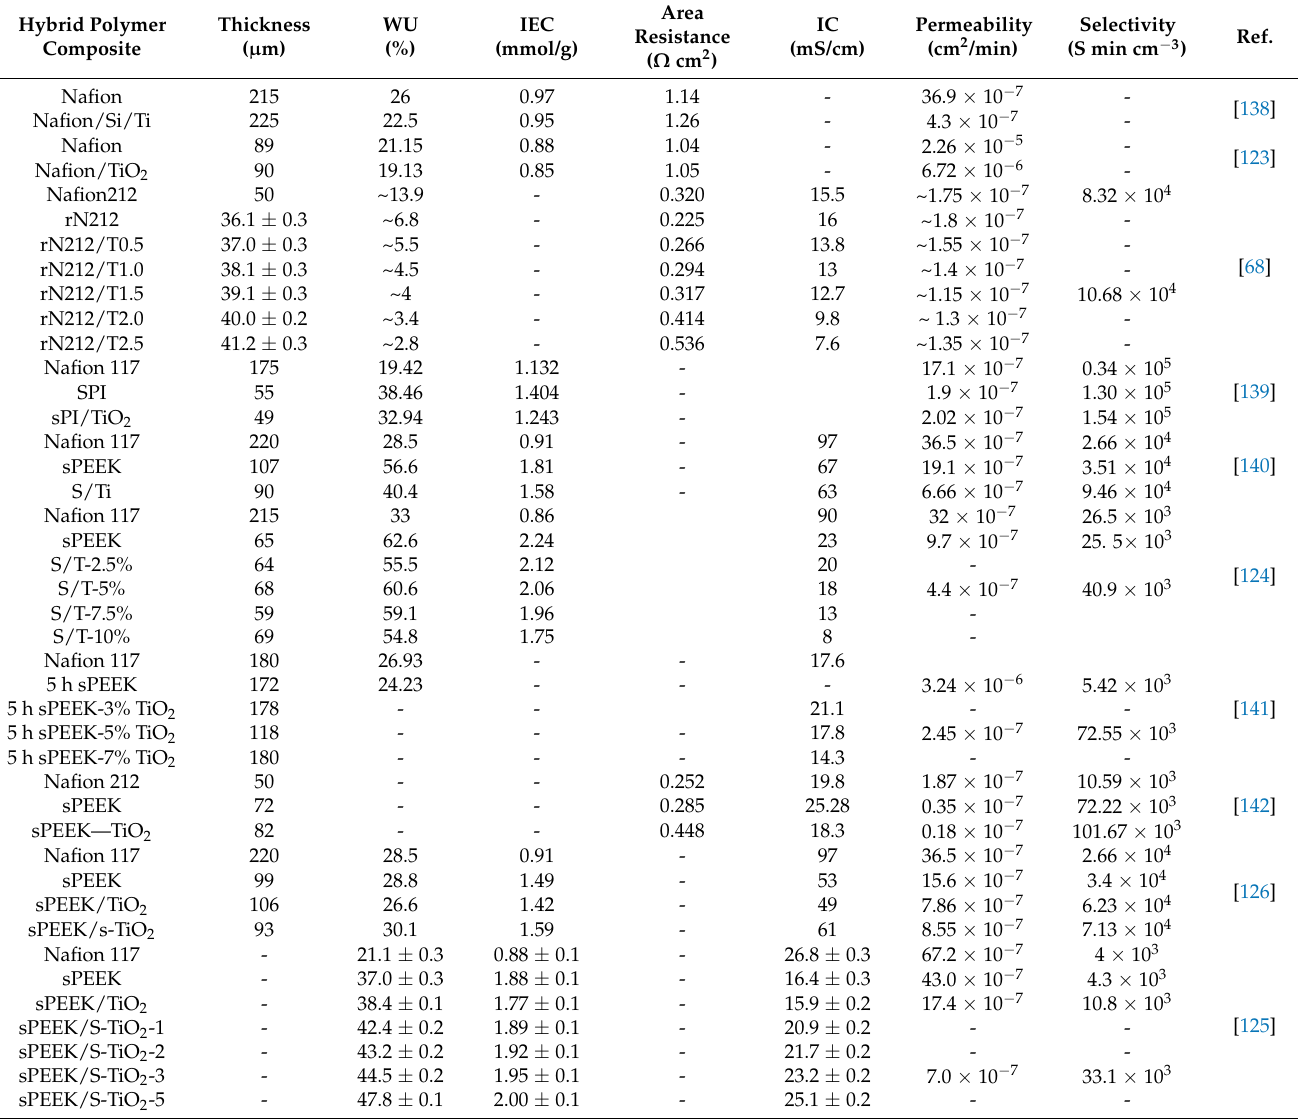
Table 1. Physicochemical properties of different polymers with TiO 2 nanofillers as a hybrid membrane for VRFB.